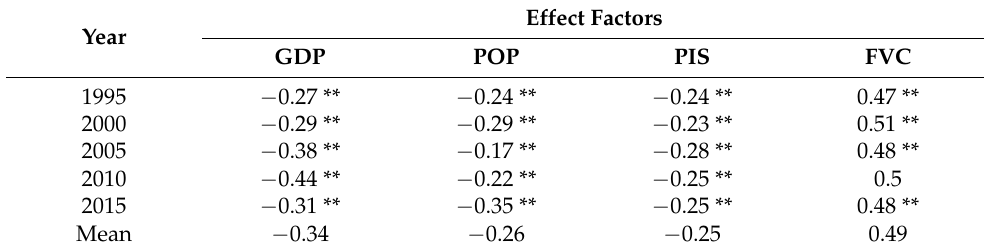
Table 5. Pearson’s correlation coefficients of habitat quality in relation to POP, PIS, GDP and FVC. Year